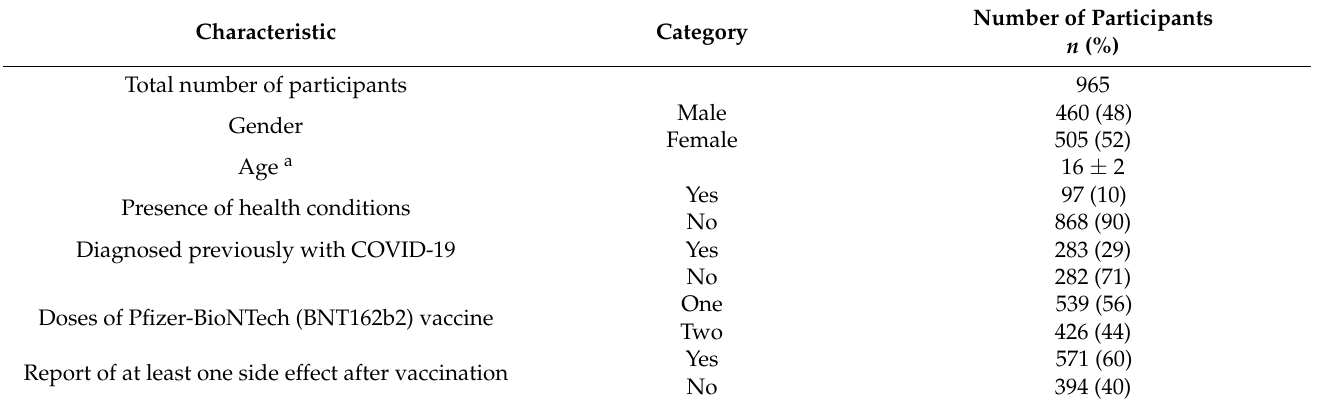
Table 2. General characteristics of study participants.